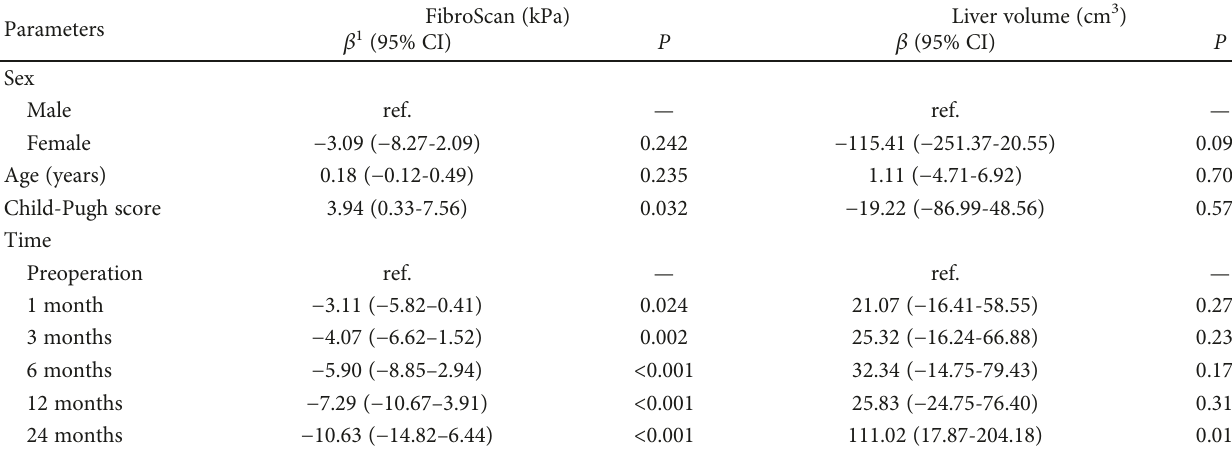
Table 4: Multivariate linear regression of imaging markers with GEE